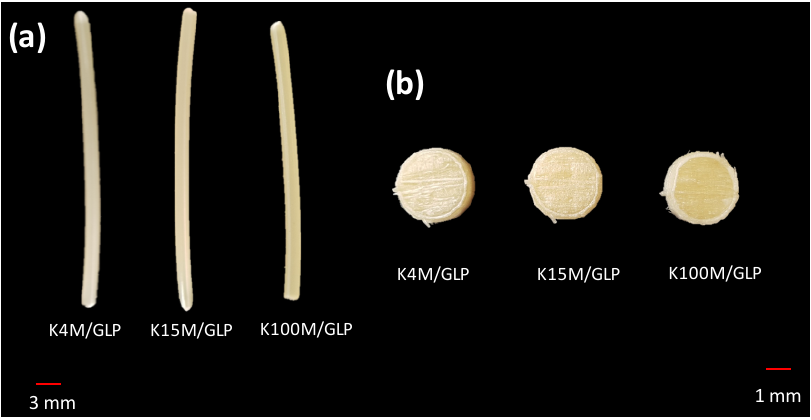
Figure 1. ( a ) Hot melt extruded filaments and ( b ) 3D printed hydrophilic matrices. Table 3. Drug loading and three-point bending results of filaments (* n = 10, standard deviations are in parenthesis).